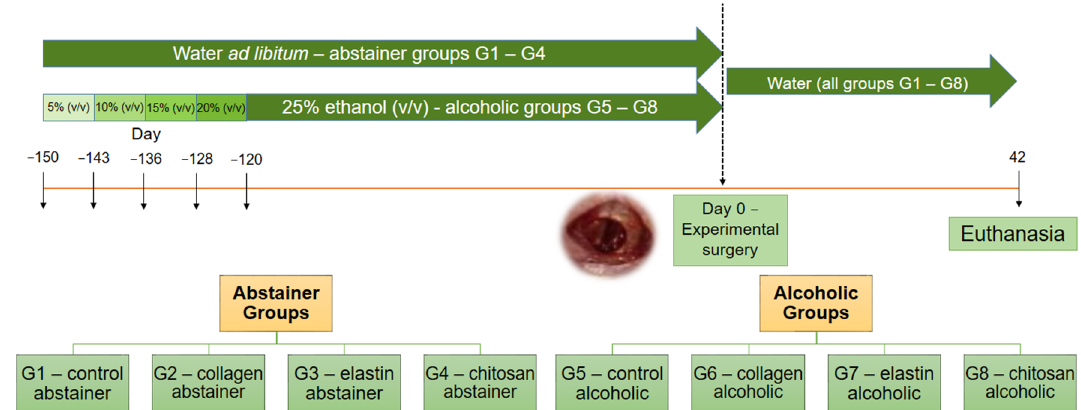
Figure 1. Study design timeline: 40 rats were divided into eight groups of 5 animals each. Twenty animals received tap water (abstainer groups G1 to G4) and twenty animals were submitted to experimental alcoholism with 25% ethanol (alcoholic groups G5 to G8), with previous gradual adaptation to increasing alcohol concentrations ( − 150 to − 120 days). After 1 month of adaptation to experimental alcoholism, the concentration of 25% was maintained for an additional 4 months in groups G5 to G8. On day 0, all animals of the eight groups underwent surgery for the creation of an experimental nasal bone defect. The bone defect was filled with clot in G1 and G5, with collagen membrane in G2 and G6, with elastin membrane in G3 and G7, and with chitosan membrane in G4 and G8. After surgery, all animals continued to receive tap water and were euthanized at 42 days post-surgery.